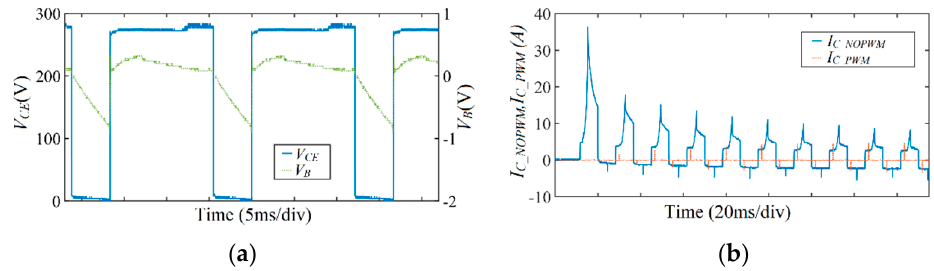
Figure 14. ( a ) V CE and V B at the high-side driver where voltage drop close to 1 V is observed; ( b ) Transformer inrush current which can reach twelve times the nominal value.